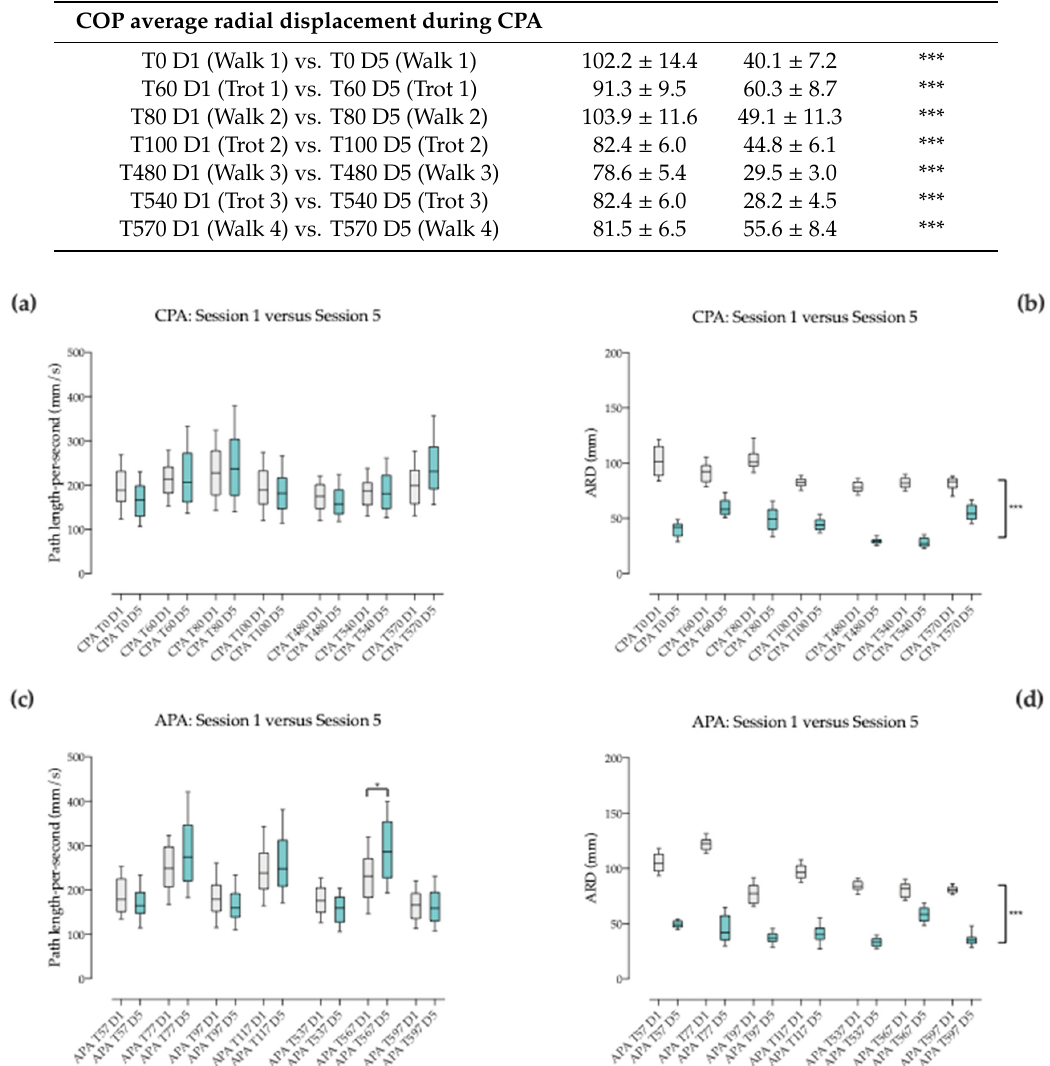
Figure 5. Box and whiskers diagrams corresponding to the comparisons of COP path length ( a ) and COP average radial displacement ( b ) during compensatory postural adjustments (CPA) and the comparisons of COP path length ( c ) and COP average radial displacement ( d ) during anticipatory postural adjustments (APA) between corresponding pace changes of sessions 1 and 5. D1 corresponds to session 1 and D5 to session 5. p < 0.05 (*), p < 0.001 (***).